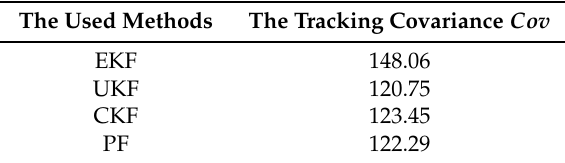
Table 4. Comparison on tracking covariance of EKF, UKF, CKF and PF with adaptive